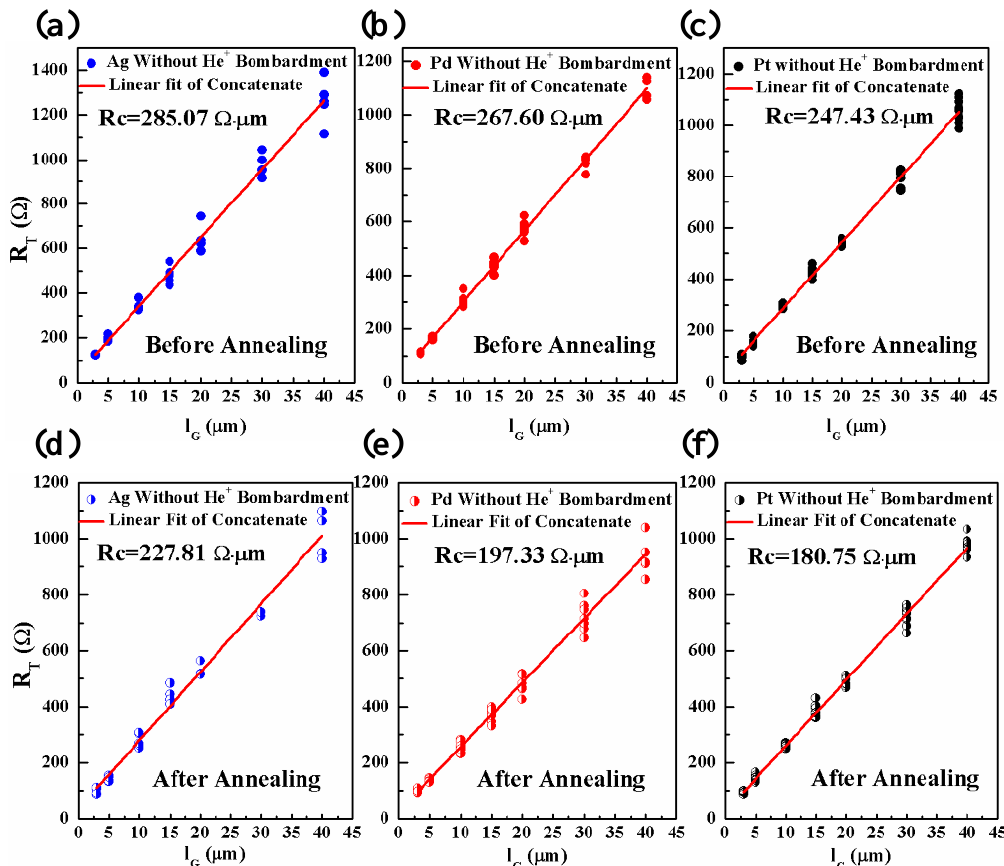
Figure 4. The linear plots of R T vs. l G for the contacts between Ag, Pd, Pt and graphene without He + bombardment before annealing ( a – c ) and after annealing ( d – f ). For each l G , 10 data points are used and the liner fitting is performed using concatenate fit method. Extracted R c value is shown in each corresponding plot.